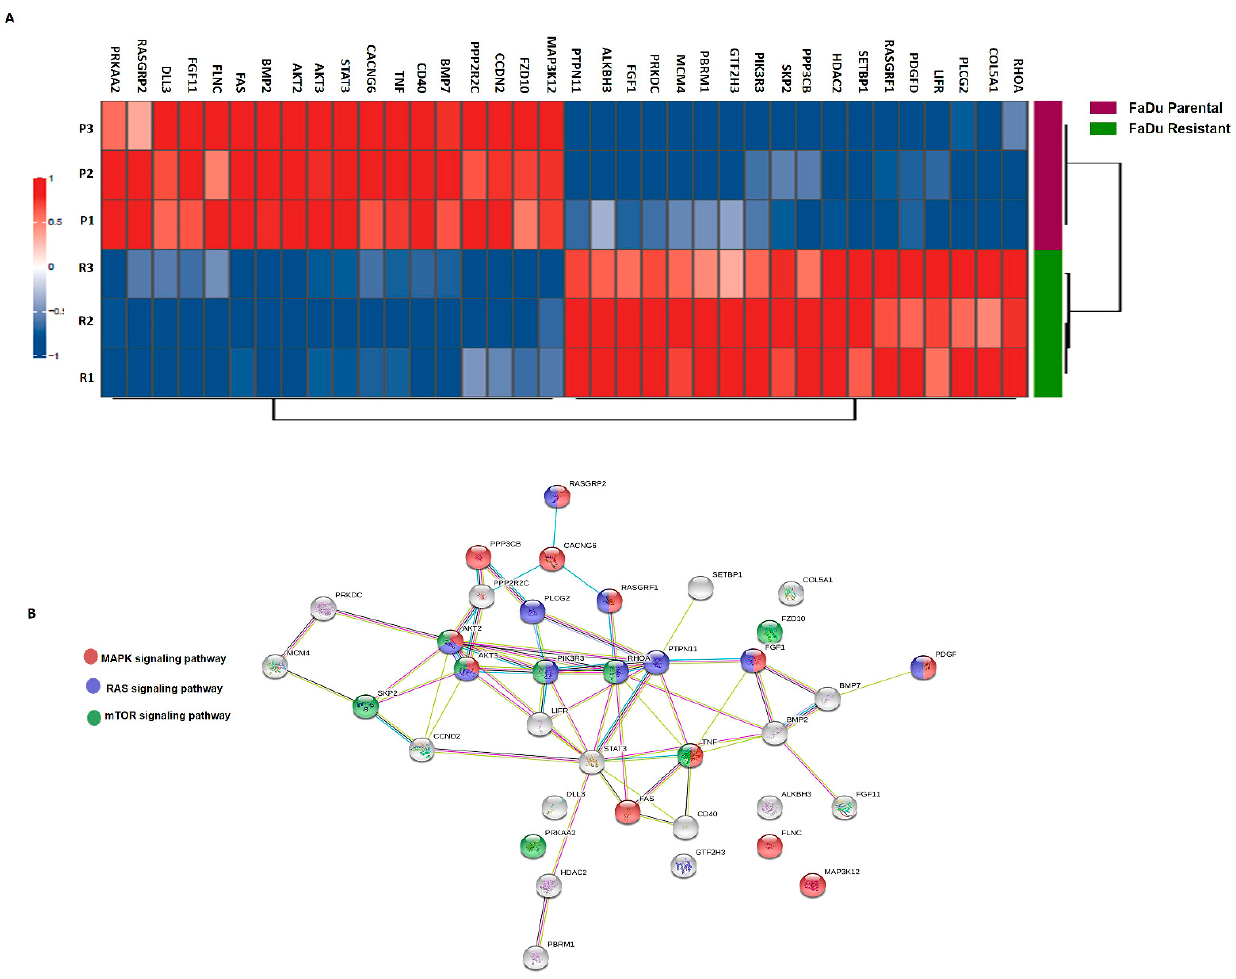
Figure 3. Molecular characterization after cetuximab-acquired resistance. ( A ) Heatmap of genes altered in FaDu parental and FaDu resistant cells. In red are represented the overexpressed genes, and in blue the downregulated genes. FaDu parental is shown in purple and FaDu resistant in green. ( B ) Genetic interaction network associated with cetuximab resistance on the STRING database. In this figure, each circle represents a protein (node), and each connection represents a direct or indirect connection (edge). Line color indicates the type of interaction evidence: purple—experimental evidence, light blue—curate database, black—co-expression, pink—experimentally determined, yellow—text mining, dark blue—gene co-occurrence (MAPK associated genes are shown in red, RAS associated genes are shown in blue, and mTOR signaling-related genes are shown in yellow. p. adjusted <0.01; FC ≥ 2.